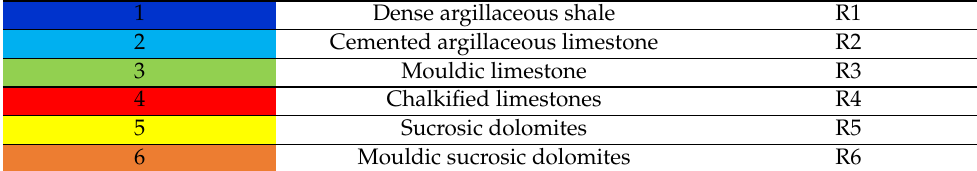
Table 5. List of 6 Lithofacies types used for IPSOM map